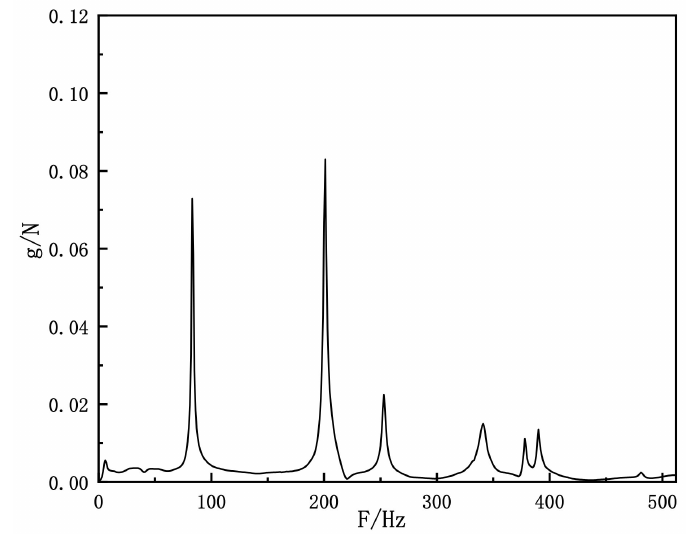
Figure 25. Integrated frequency response function curve of aluminium alloy front subframe.